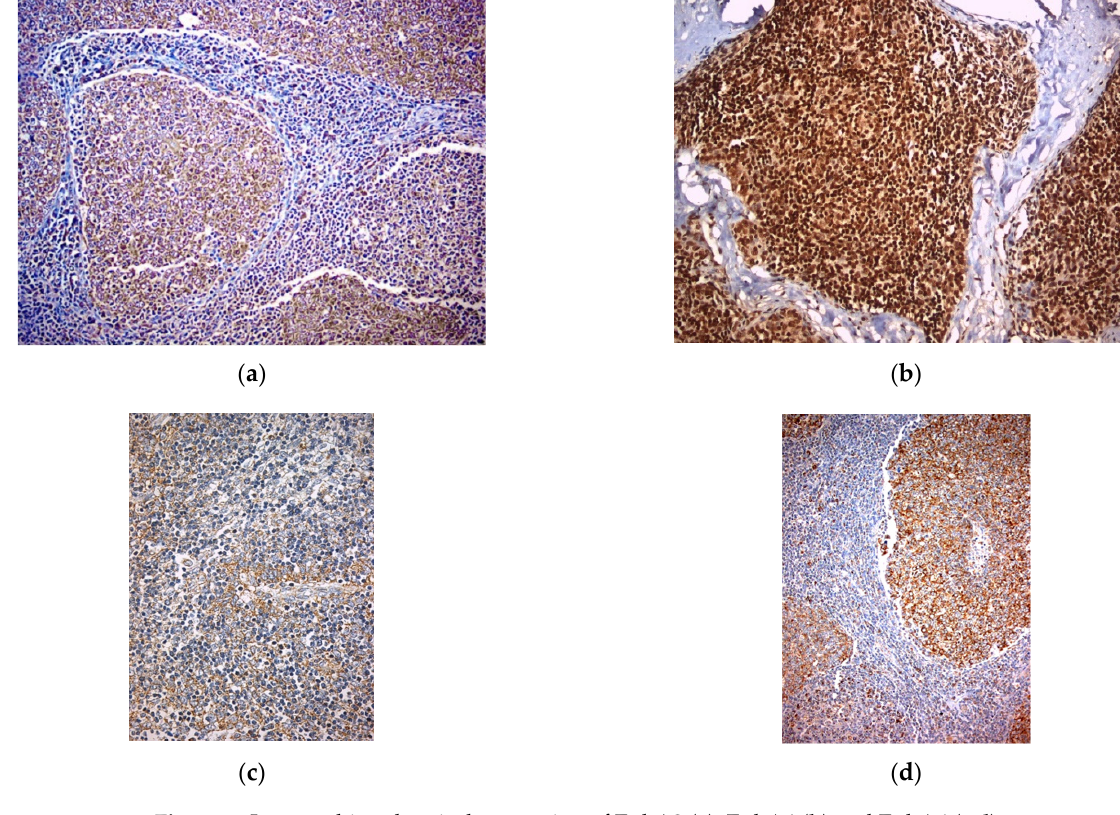
Figure 2. Immunohistochemical expression of EphA2 ( a ), EphA4 ( b ) and EphA6 ( c , d ). Table 1. Subcellular topography of Ephs.